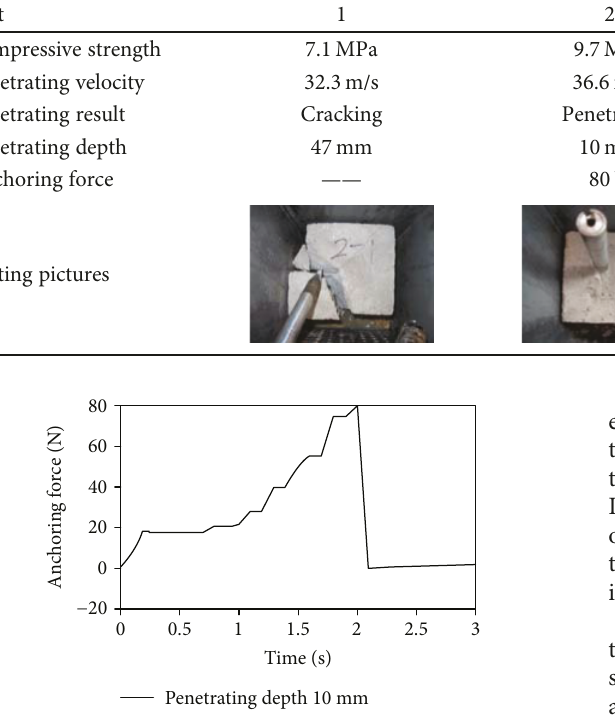
Figure 19: Anchoring force when anchor body penetrating 10mm in 9.7MPa cement